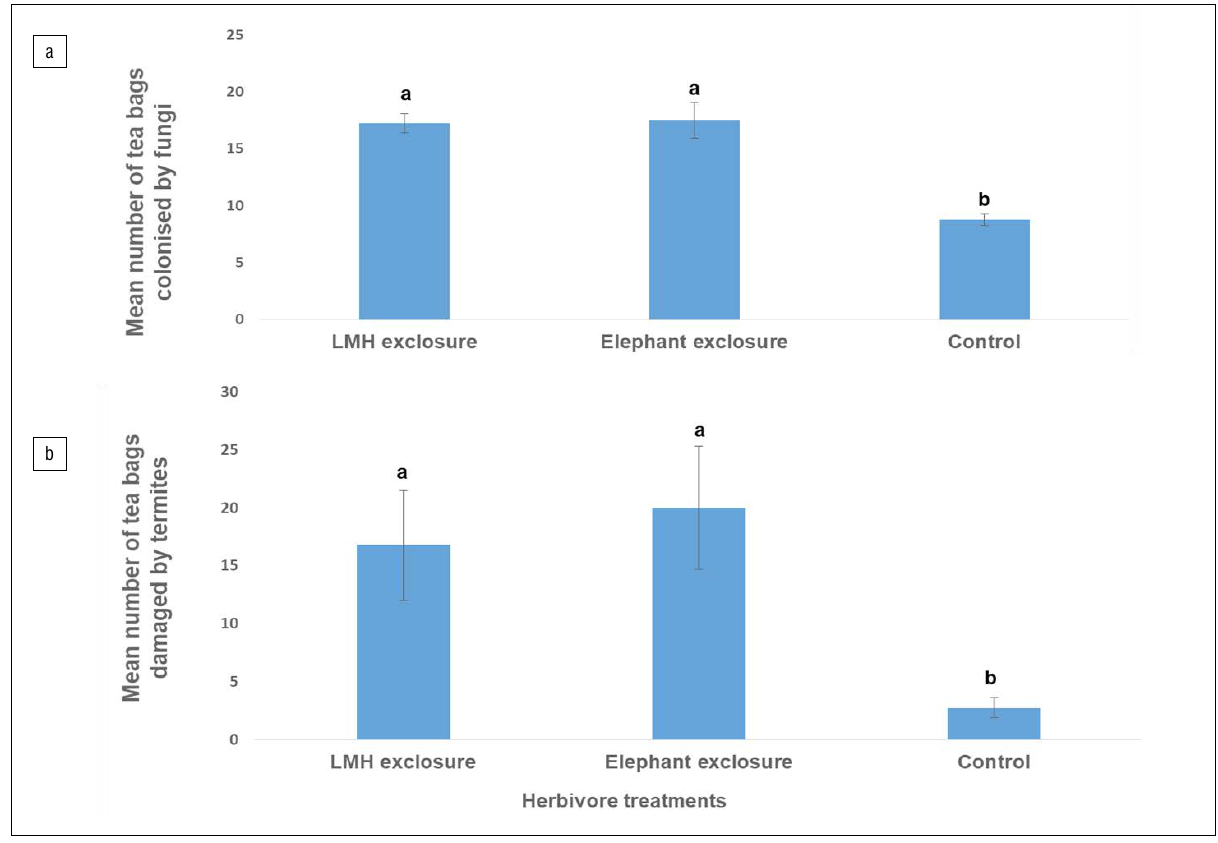
LMH exclosure, all large mammalian herbivores excluded; Elephant exclosure, elephants (and giraffes) excluded; Control, all herbivores present Figure 3: Mean number of tea bags (a) infected by fungi and (b) damaged by termites across herbivore treatments. Significant differences ( p <0.05) between herbivore treatments are indicated by different lowercase